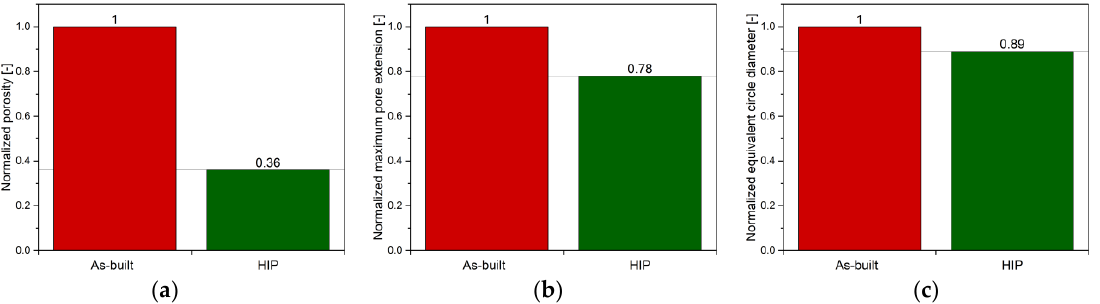
Figure 6. Difference in ( a ) porosity, ( b ) maximum pore extension, and ( c ) equivalent circle pore diameter between the as-built and HIP series. Table 3. Summary of the porosity and pore size characteristics between the as-built and HIP condition.